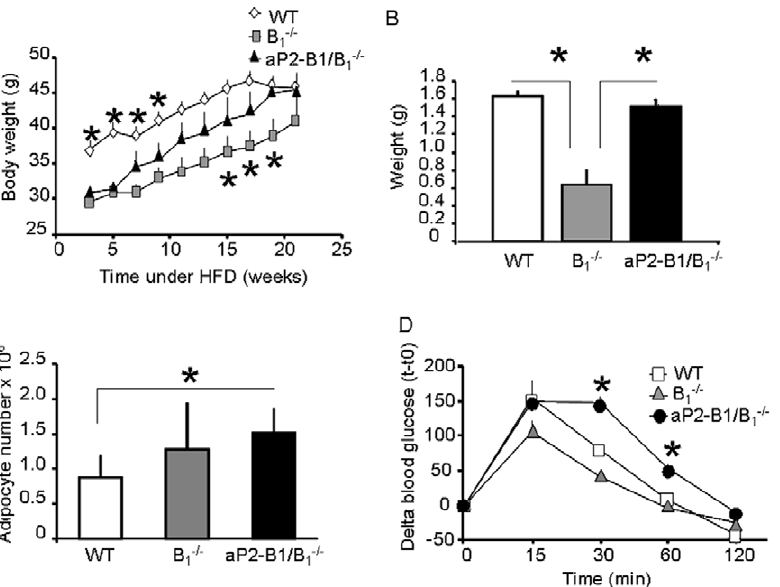
Figure 6. Kinin B 1 R in adipocytes contributes to fat accumulation and insulin resistance in response to a high fat diet (HFD). Animals were submitted to HFD. A: Body weight was monitored during the diet. *, vs. aP2-B 1 /B 1 2 / 2 ; B: Mice were sacrificed at the end of the treatment and the epididymal fat pads were weighed. C: Adipocyte number was quantified in the epididymal fat pad. D: Glucose tolerance was performed 12 weeks after the beginning of the HFD; *, aP2-B 1 /B 1 2 / 2 vs. B 1 2 / 2 and WT. Values are means 6 SEM of six animals per group. *, P , 0.05.